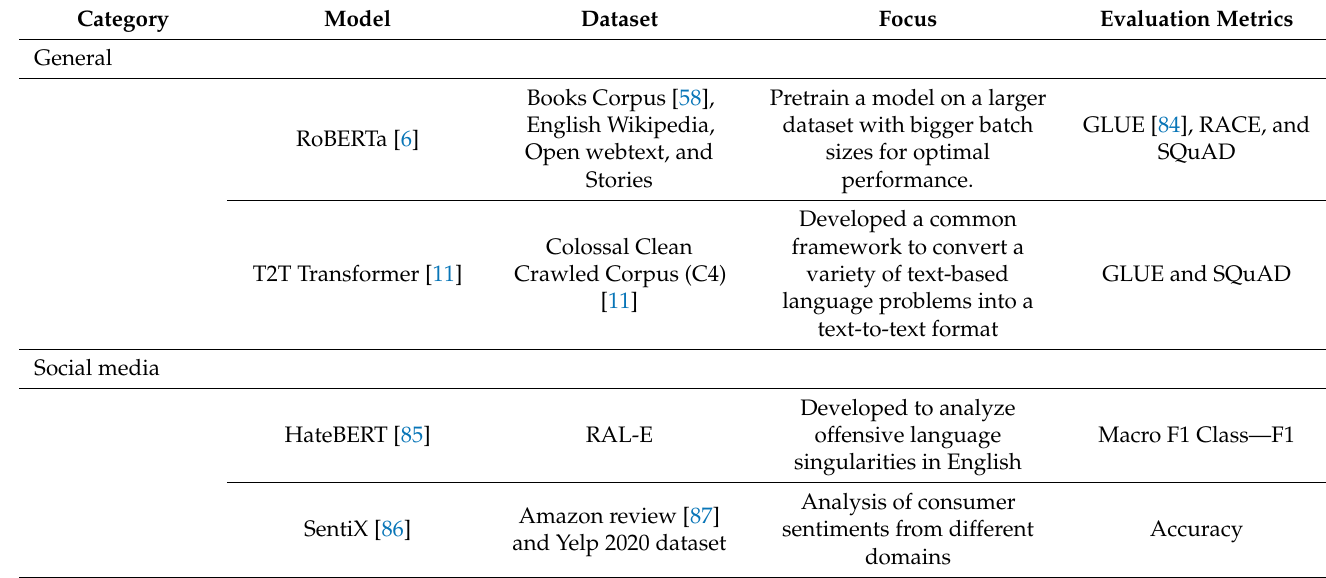
Table 3. A summary of dataset for pretraining models based on Transformer